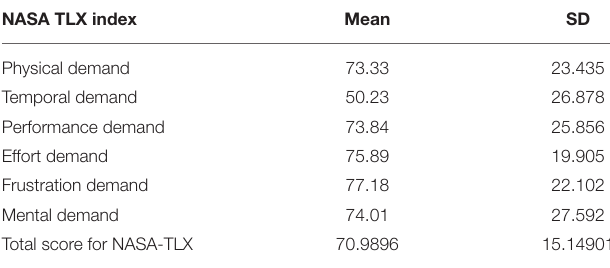
TABLE 1 | Demographic variable. TABLE 2 | Mean and standard deviation (SD) Scores obtained for NASA-TLX